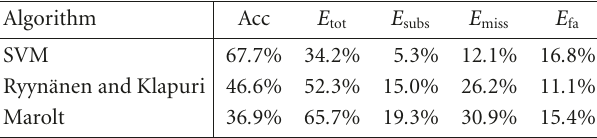
Table 1: Frame-level transcription results on our full synthesized- plus-recorded test set.